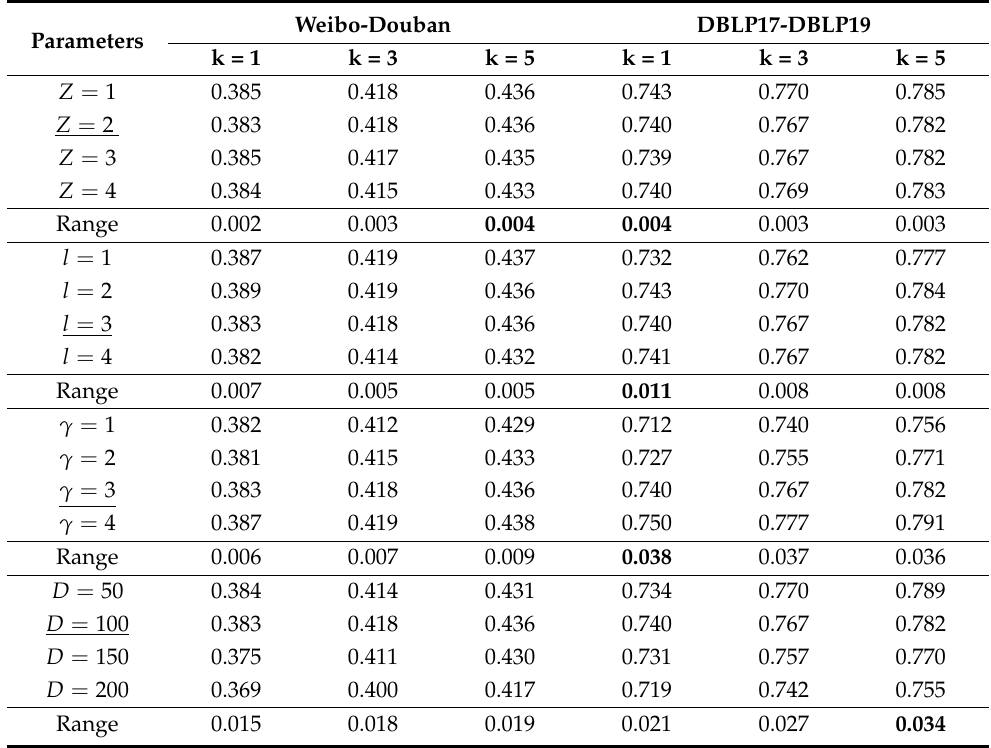
Table 4. Parameter sensitivity experiment